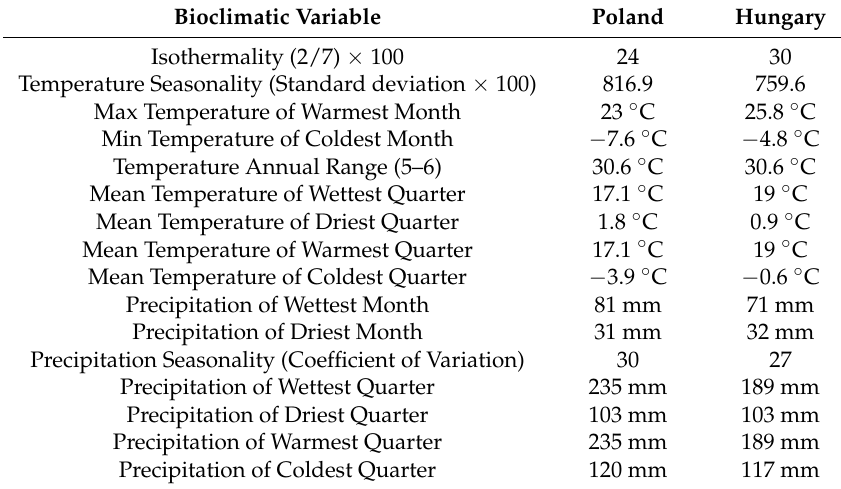
Table 1. Selected for comparison of study sites bioclimatic variables